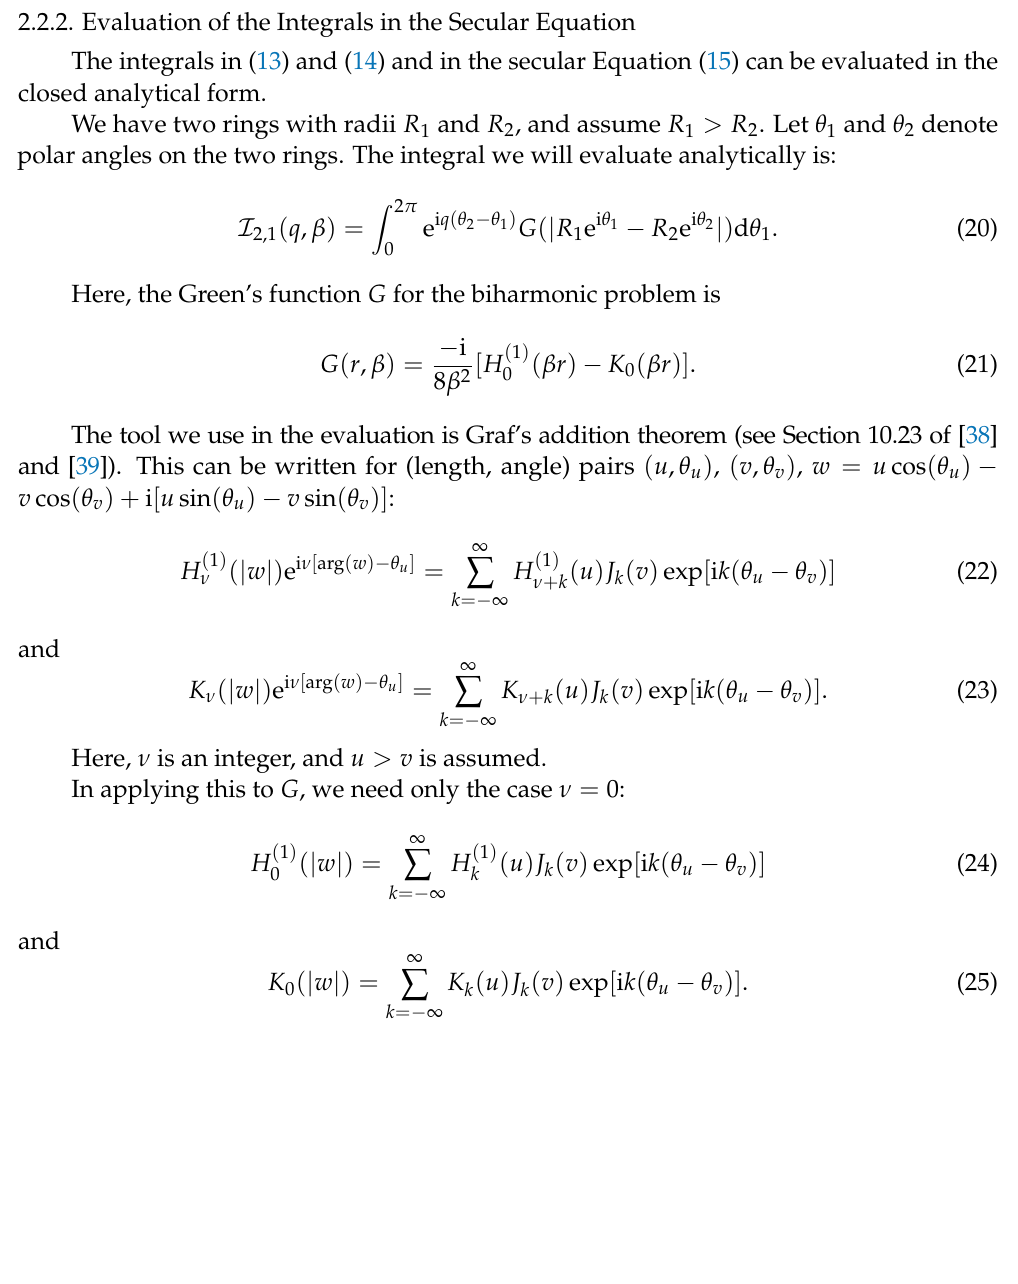
Figure 3. Plate incorporating a double-ring of masses or spring-mass